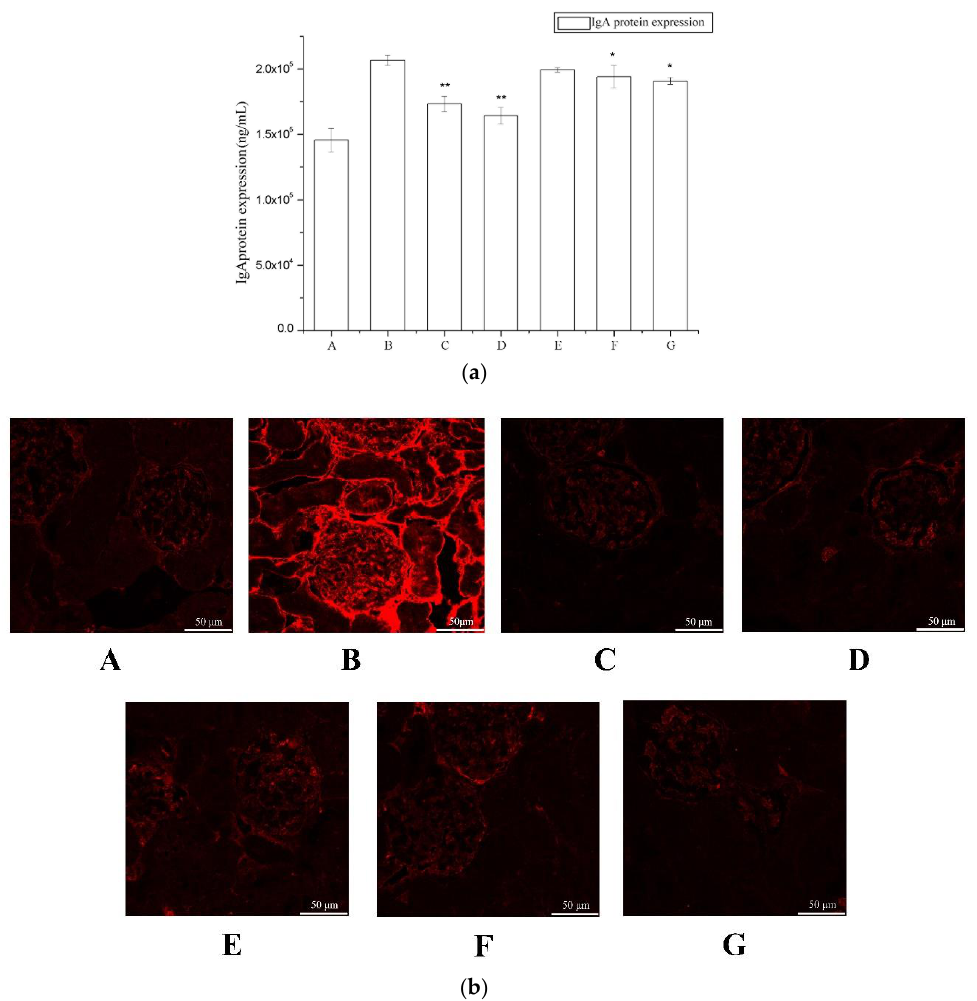
Figure 3. The effect of periostracum cicadae on IgA deposition. ( a ) Effects of periostracum cicadae on serum IgA levels in IgAN rats (* p < 0.05, ** p < 0.01). ( b ) Immunofluorescence staining of IgA in the